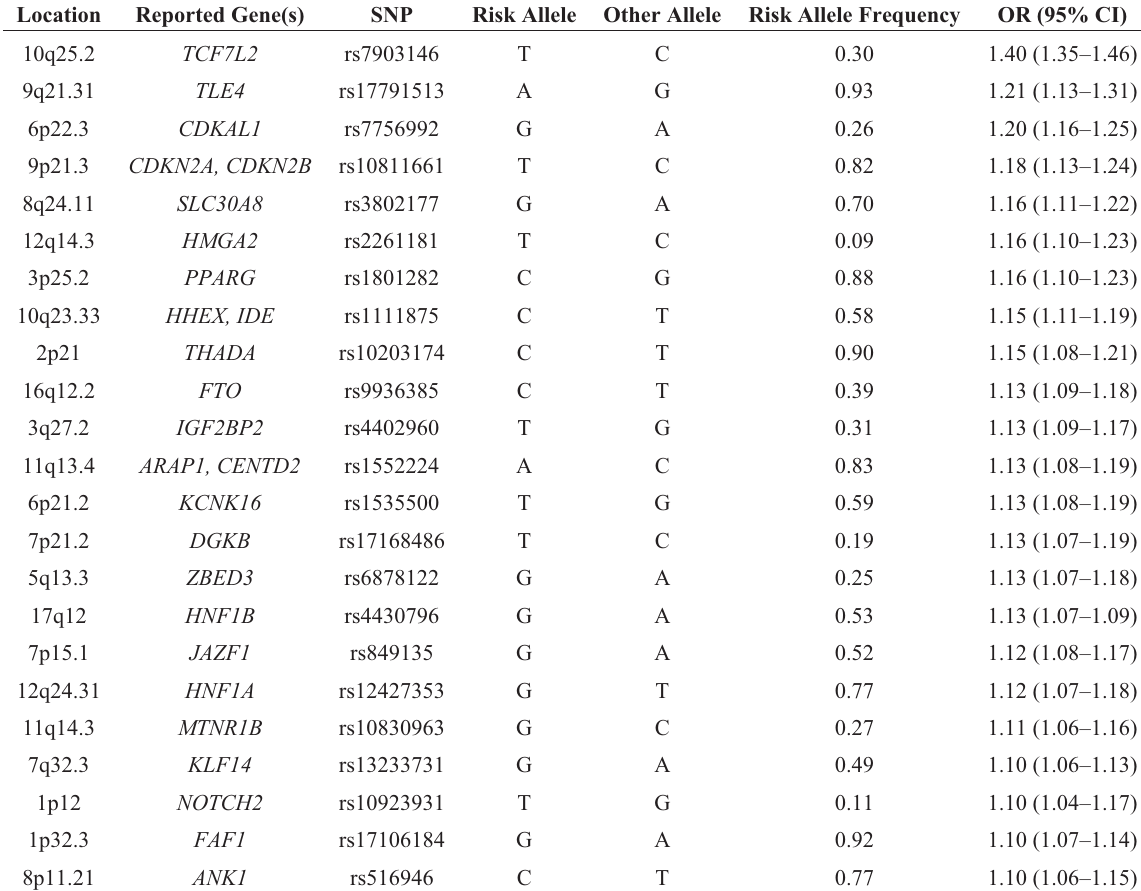
Table 1. List of identified common variants associated with Type 2 diabetes in populations of European ancestry utilizing a case-control design. Effect estimates drawn from European data from Mahajan et al. , 2014 [33] or largest GWAS